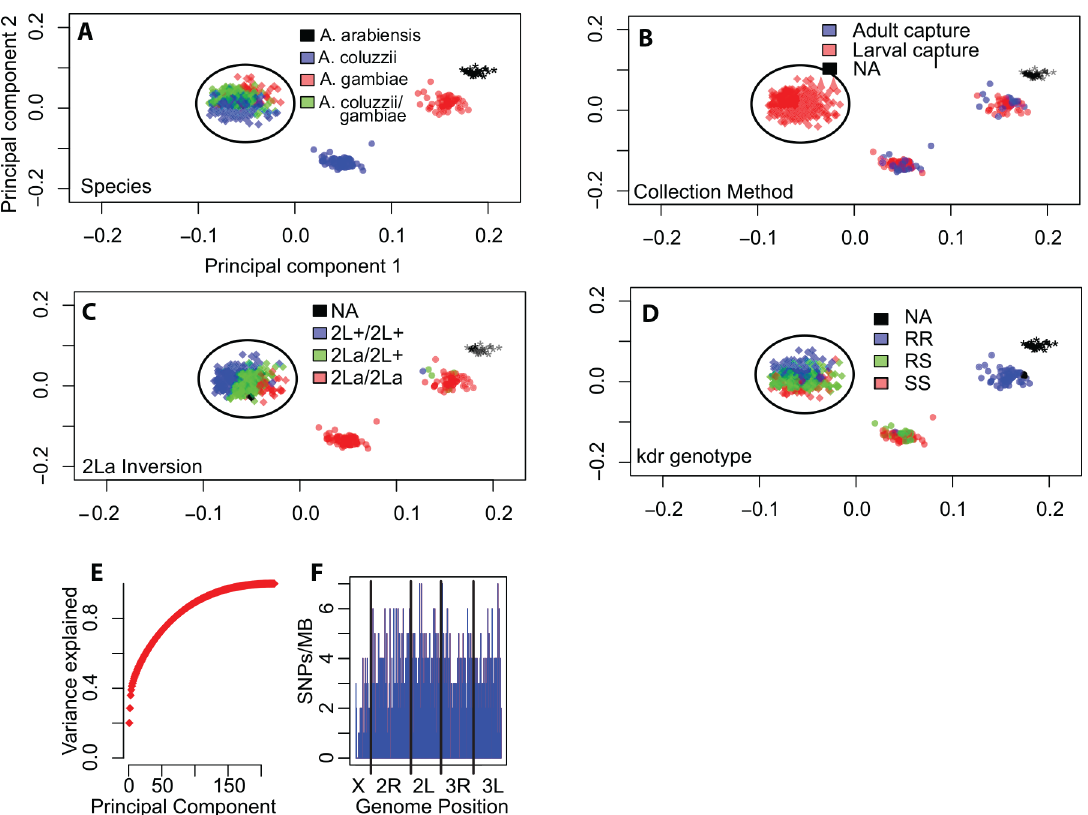
Fig 1. A comprehensive image of population structure is provided by genome-wide SNP typing in a local Anopheles population. Principal component analysis (PCA) was performed on 812 genome-wide, uniformly spaced SNPs typed in 422 individual mosquitoes collected in the village of Goundry, Burkina Faso over two years. A-F, Symbol color represents genetic attributes determined by molecular assays. A) species, B) collection method, C) genotype of 2La inversion, and D) genotype of kdr insecticide resistance-associated SNP. Axis labels for (A-D) as in (A). E) The cumulative variance of the PCA explained as a function of the number of principal components. The first two components explain greater than 25% of the variation. F) Distribution of SNP markers across the genome. Vertical blue bars indicate the number of SNPs per Mb, vertical black bars indicate the breakpoints between chromosome arms. The circled cluster in all panels indicates those individuals belonging to the Goundry